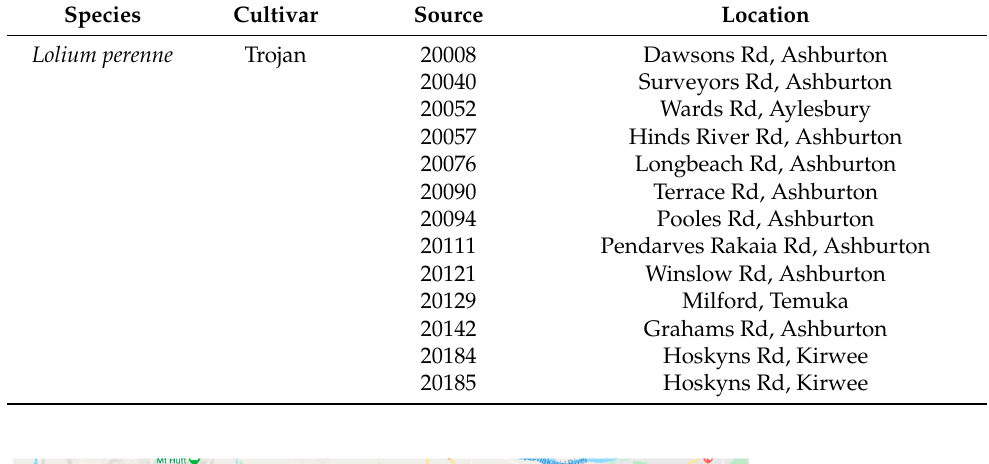
Table 2. The biogeographical locations of Biogeography Seed accessions.